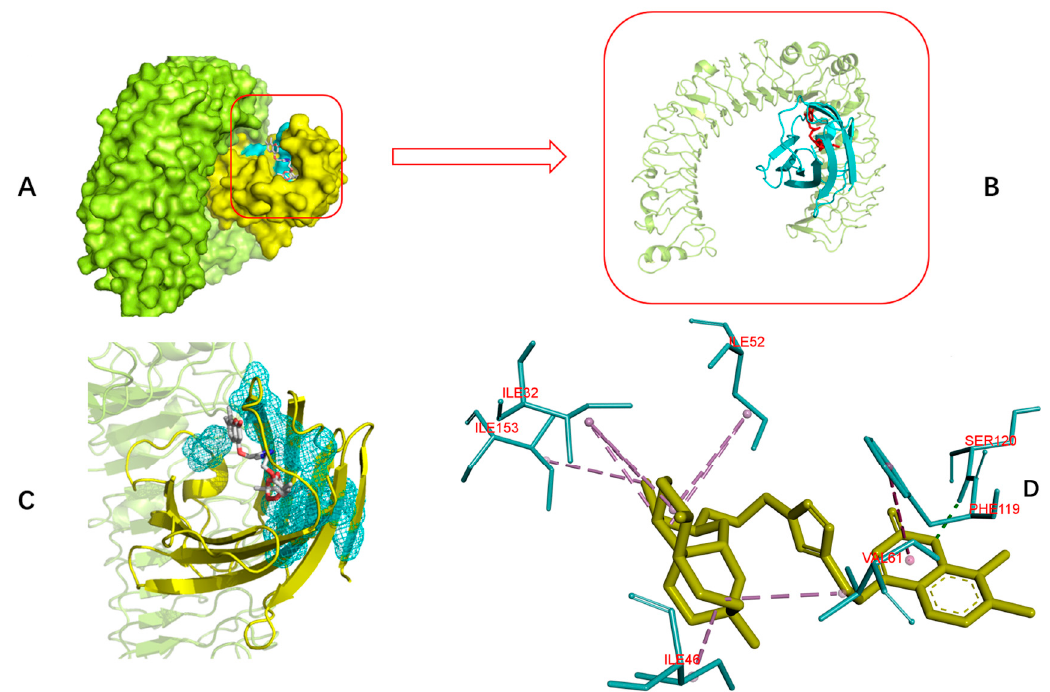
Figure 5. Interaction diagrams of the selected docked conformations of compound 5n to TLR4 / MD-2 complex. ( A ) The surface representation of compound 5n and TLR4 (limon) / MD-2 (yellow) binding pocket. ( B ) The magnified representation of compound 5n (red) and TLR4 (limon) / MD-2 (cyan) binding pocket. ( C ) The interface of compound 5n and TLR4 / MD-2 complex; ( D ) 3D ligand interactions diagram. Dotted line; pink: alkyl hydrophobic; blue: pi hydrophobic; green: hydrogen bond.